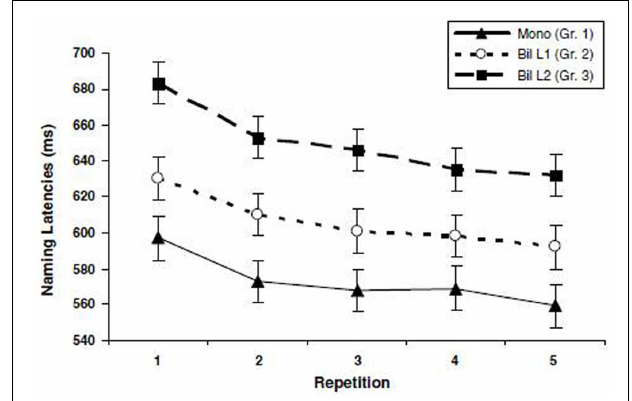
FIGURE 1 | Figure taken from Ivanova and Costa (2008). Overall mean picture naming latencies for the Spanish Monolinguals (Group 1), the Spanish–Catalan Bilinguals (Group 2), and the Catalan–Spanish Bilinguals (Group 3) tested in Ivanova and Costa (2008), averaged across high-frequency and low-frequency picture names. Error bars represent the